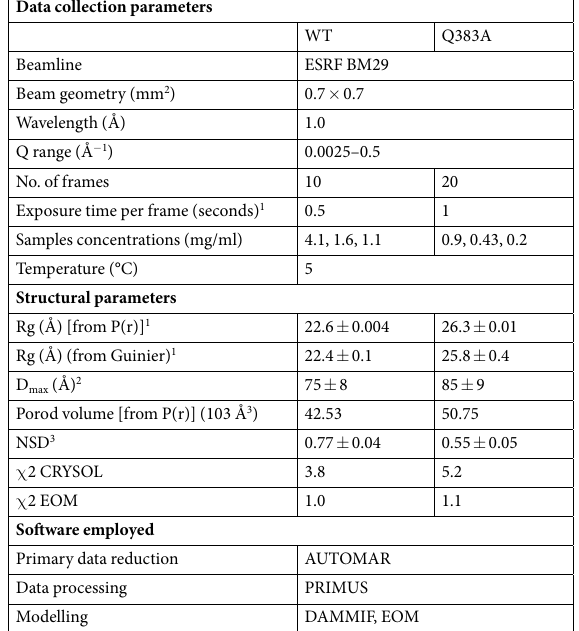
Table 2. Data collection and scattering-derived parameters. 1 ± S.E. 2 ± 10% (estimated range). 3 NSD, normalized shape discrepancy for DAMMIF